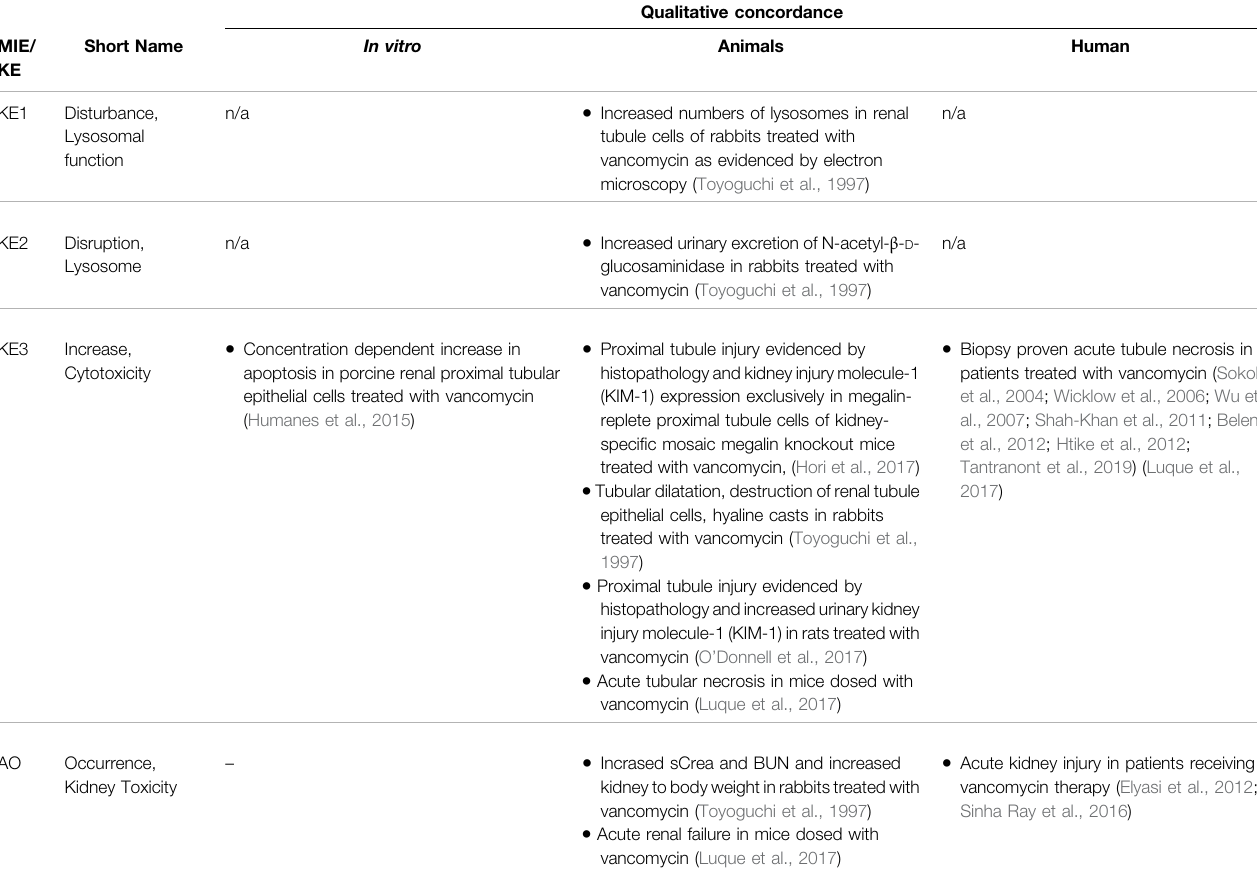
TABLE4C| Evidencefromhuman,animaland invitro studieson vancomycin supportingthekeyeventsandqualitativeconcordanceofKEswithinthisAOP(n/a=notdata